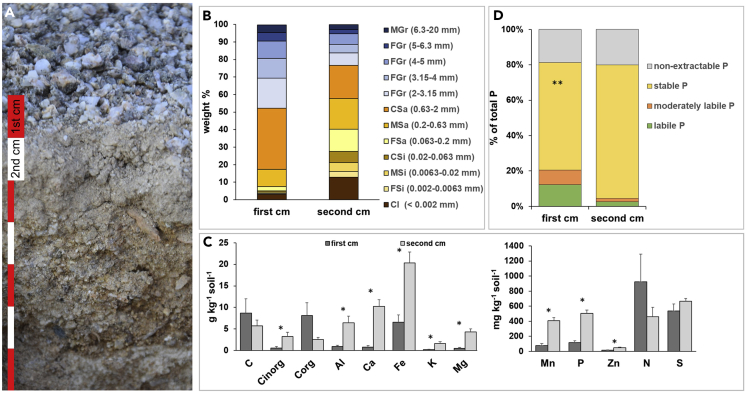
Texture and Elemental Composition of the First and Second Centimeter of a Grit Crust Profile(A) Upper centimeters of a terrestrial protopedon profile with accumulated fine material between and underneath the grit stones; red and white scale bars represent 1 cm each; (B) Texture of the first and second centimeter of the profile; C = coarse, M = middle, F = fine, Gr = gravel, Sa = sand, Si = silt, Cl = clay; (C) Elemental composition of the first and second centimeter of the profile represented as mean +/− standard deviation; asterisks indicate significant differences between an elemental concentration of the first and second centimeter, p ≤ 0.1, paired t test; (D) P pools as percentage of total P in the first and second centimeter of the profile; asterisks indicate significant differences between first and second centimeter within one fraction at ∗∗p ≤ 0.05, paired t test.